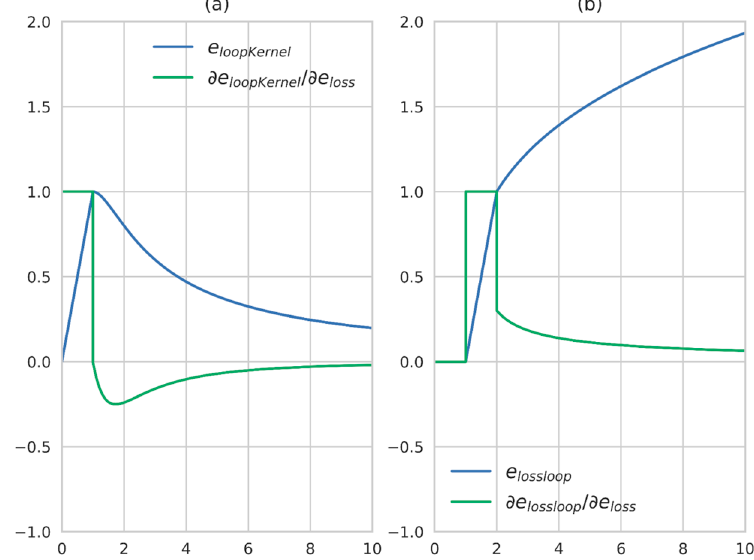
Figure 10. Image of different error functions. ( a ) The function value of different error functions. ( b ) The derivative of different error functions.